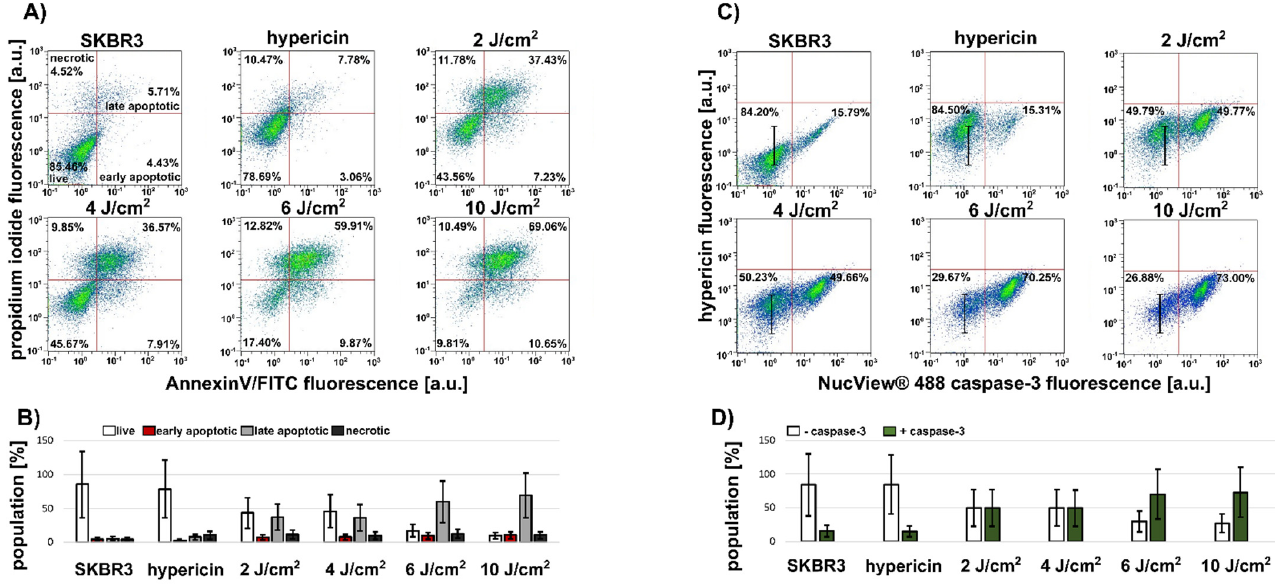
Figure 2. ( A , B ) Flow cytometric analysis of apoptotic (AnnexinV/FITC positive) and necrotic (pro- pidium iodide positive) cell populations triggered in SKBR3 spheroids in the presence and absence of 500 nM hypericin and 24 h after application of different light doses 2–10 J/cm 2 . ( C , D ) Flow cytometric analysis of caspase-3 by NucView ® 488 caspase-3 substrate and hypericin (intensity shift is denoted with black marker) fluorescence detection in cells of SKBR3 spheroids. Cell number is color coded from blue (minimum) to red (maximum). Error bars are standard deviations of measurements. Experiments were performed in duplicate. Quadrants in A were selected to distinguish live (white columns), early apoptotic (red columns), late apoptotic (grey columns), and necrotic (dark grey columns) cells. Quadrants in ( C ) were selected to distinguish caspase-negative (left quadrants and white columns) and caspase-positive (right quadrants and green columns) cells.